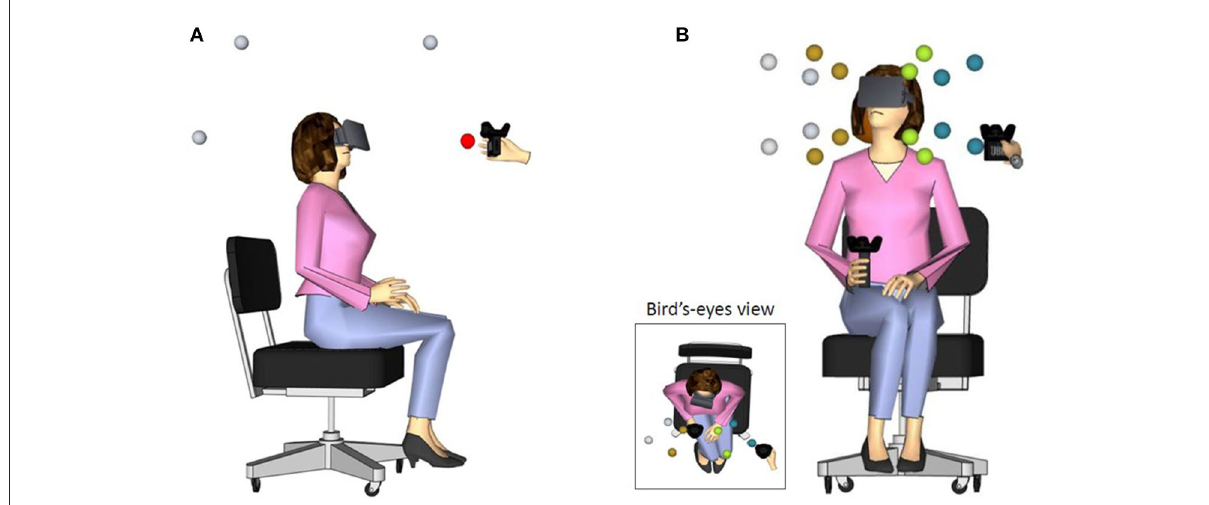
FIGURE1 Schematic description of participant wearing the HMD in (A) the front-back discrimination task (lateral view) and (B) in the 3D sound localization in front space task (front and bird’s-eye view). The spheres around the participant’s head indicate the target positions. Different azimuth positions are marked by different colors only for illustrative purposes. The experimenter brought the tracked speaker (also shown in figure) at the pre-determined location identified in each